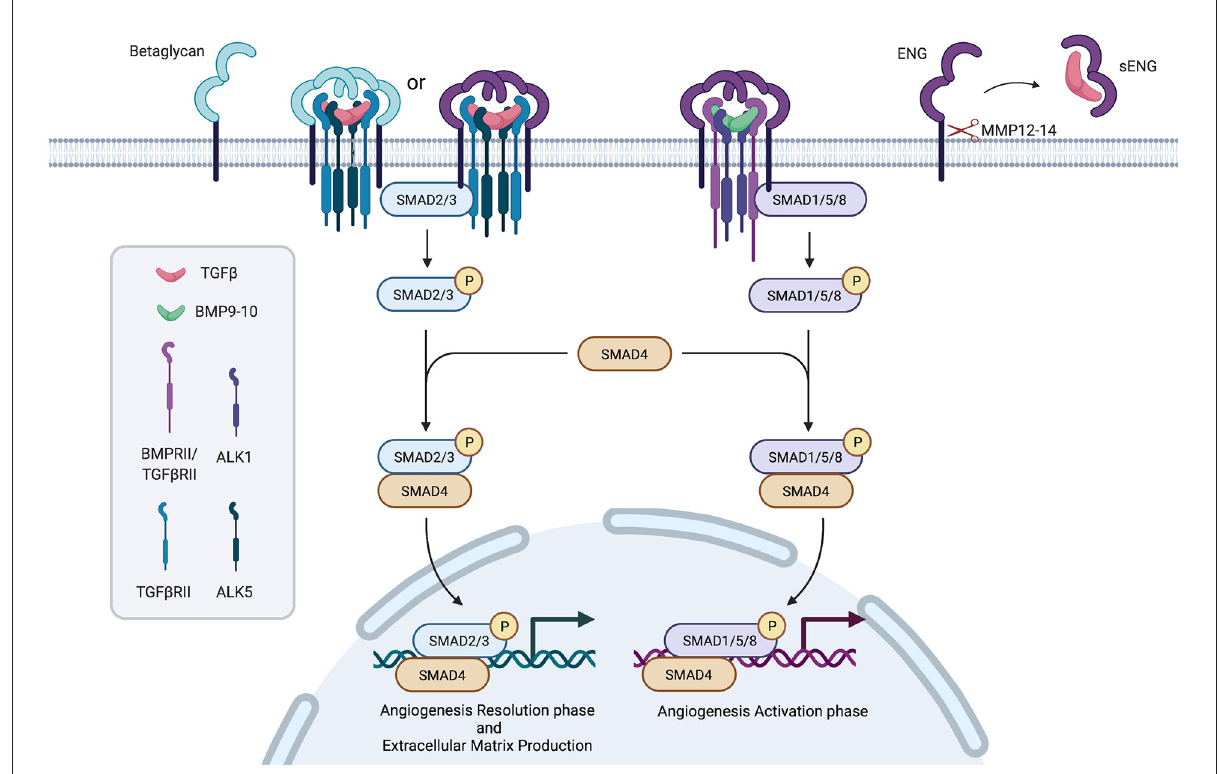
FIGURE1 Simplified representation of the TGF β /ENG pathway. Created with BioRender.com.